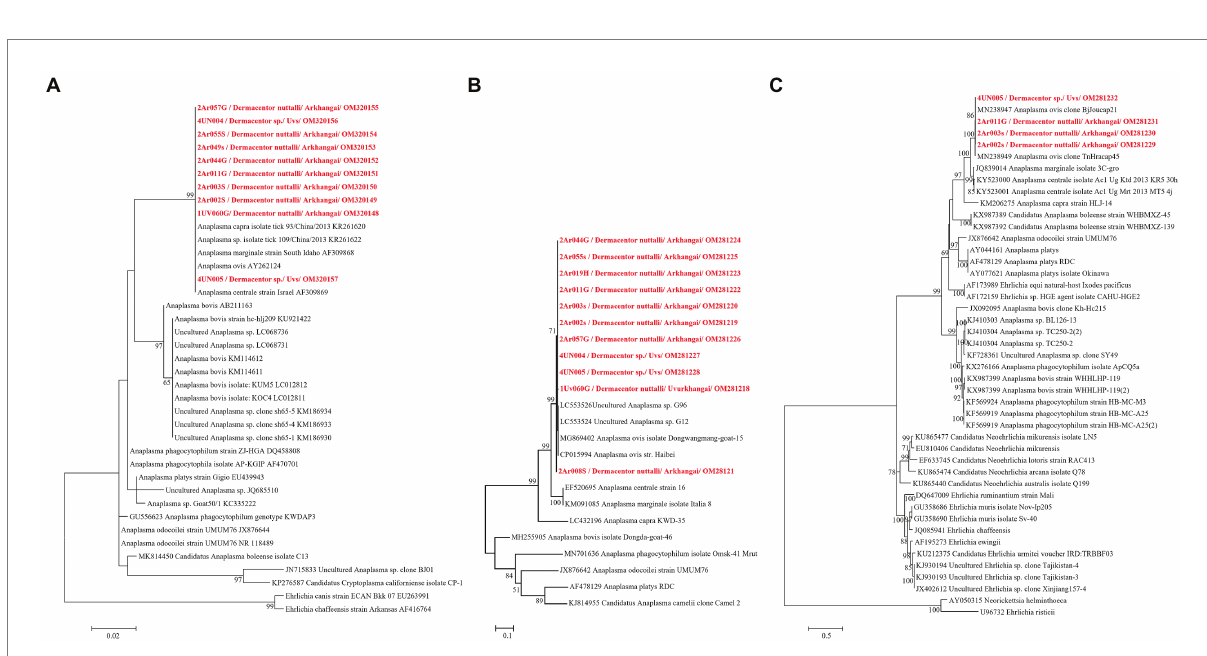
FIGURE 4 ML tree was constructed from 16S rRNA (A) and groEL genes using K9 + G (B) and TN93 + G + I (C) models, respectively, with 1,000 bootstrap and value over 50% are indicated on each